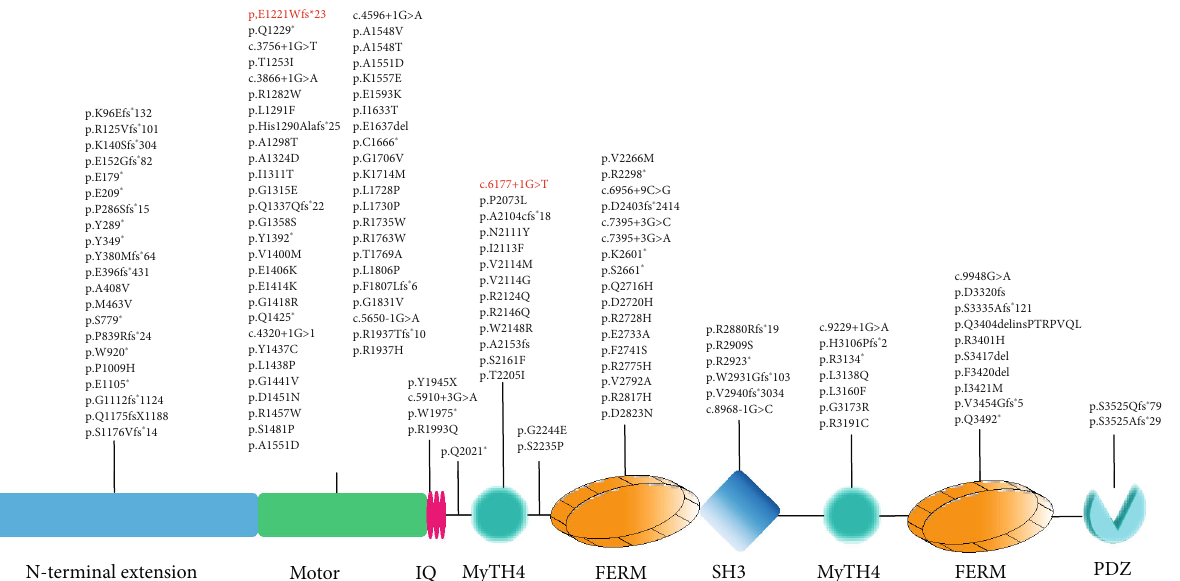
Figure 4: Schematic representation of the reported mutations in MYO15A and the corresponding protein structure. Mutations identi fi ed in this study were marked in